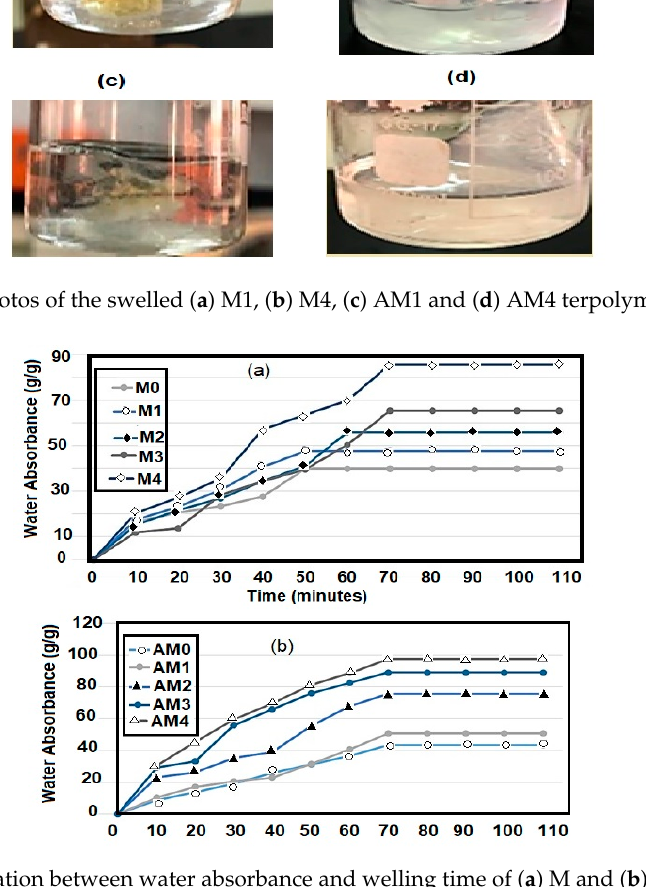
Figure 5 . Relation between water absorbance and welling time of ( a ) M and ( b ) AM gels.